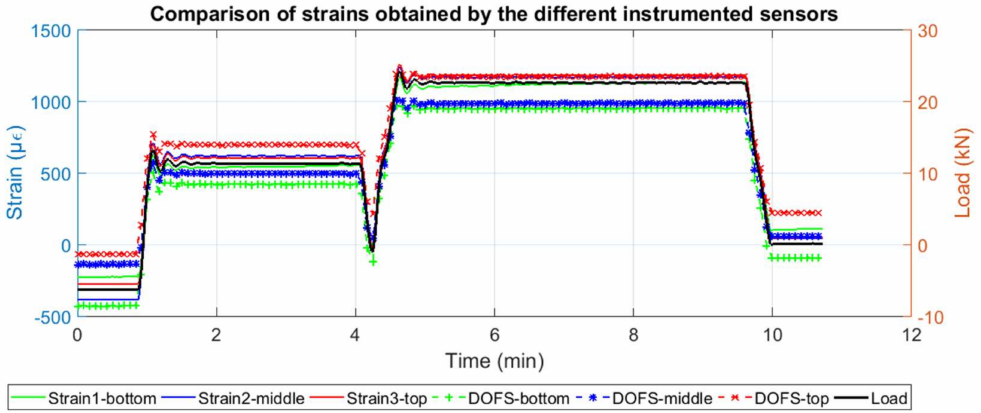
Figure 6. Comparison of strains obtained by the two different sets of deployed